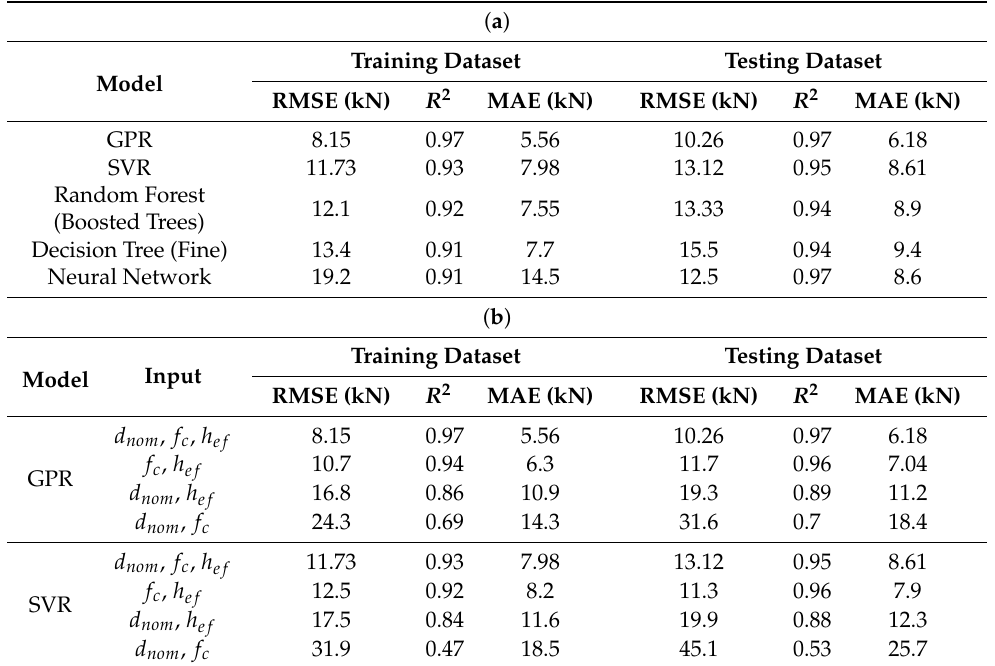
Table 3. ( a ) Results for various algorithms; ( b ) influence of input variables on Gaussian Process Regression (GPR) and Support Vector Regression (SVR) model performance.